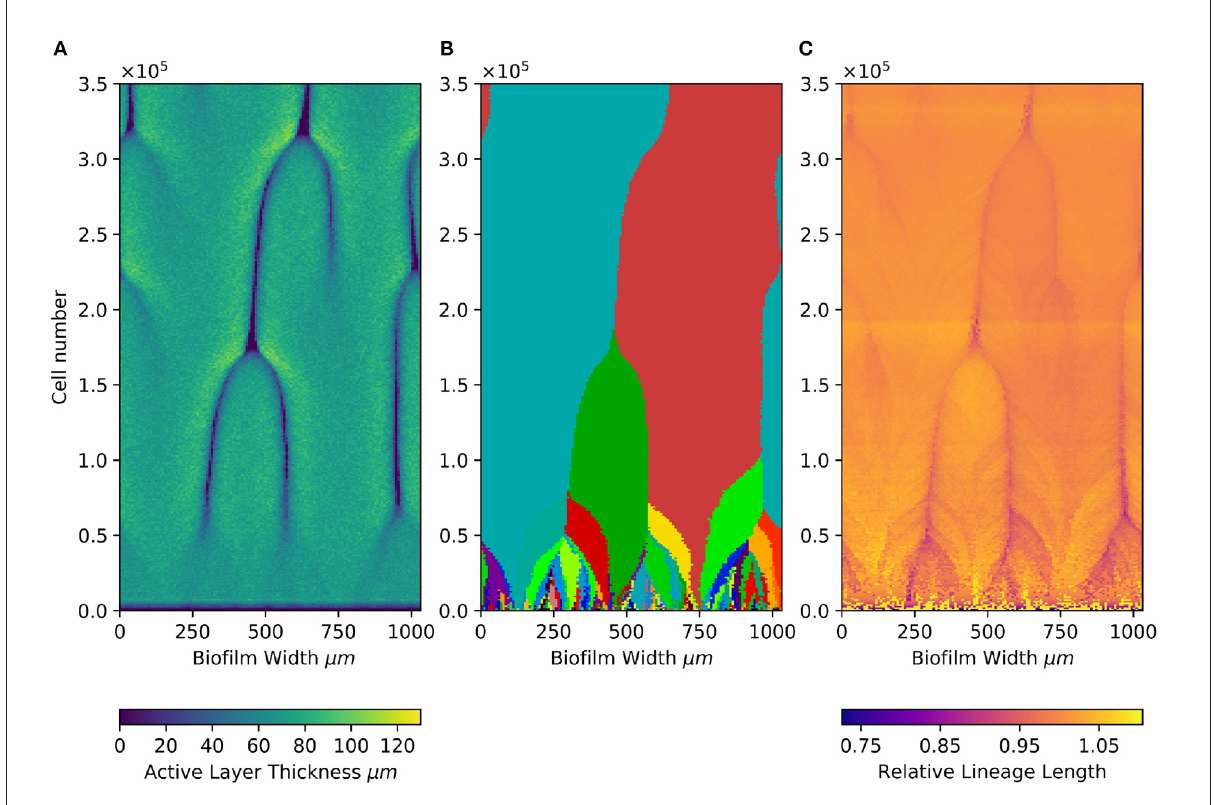
FIGURE3 Local active layer dynamics affects both loss of standing diversity and patterns of de novo diversity. Kymographs showing (A) dynamical changes in the active layer, (B) dynamics of the 300 founder lineages, and (C) dynamics of the relative lineage length at different positions along the biofilm interface. Results are shown for the simulation at intermediate active layer thickness [ 71.30 ± 1.42 µ m ( S bulk = 0.005 g / L ; µ max = 0.2 ; middle row in Figures 1, 4)], In this simulation, the active layer shows transient gaps (Young et al., 2022). (A) Shows how the local active layer thickness (colorscale) across the width of the biofilm (horizontal axis) changes during biofilm growth (vertical axis show the total number of agents in the biofilm, as a proxy for time). The darker lines correspond to the movement of local gaps in the active layer. The merger of two dark lines happens when a bulge in the biofilm interface is subsumed by two adjacent bulges and is lost behind the growing front (Young et al., 2022). (B) Shows the founder cell lineages present at the biofilm interface. Lineages of the 300 founder microbes are indicated using the same colors as in Figure 1. (C) Shows the dynamics of the relative lineage length (color scale) for microbes located at the interface. The relative lineage length is calculated as the lineage length of an individual microbe located at the interface, divided by the average lineage length of all the microbes located at the interface at that time point. Plotting the relative lineage length makes it easier to see local trends which would be obscured by the much larger general increase in lineage length with time as the biofilm grows (Figure